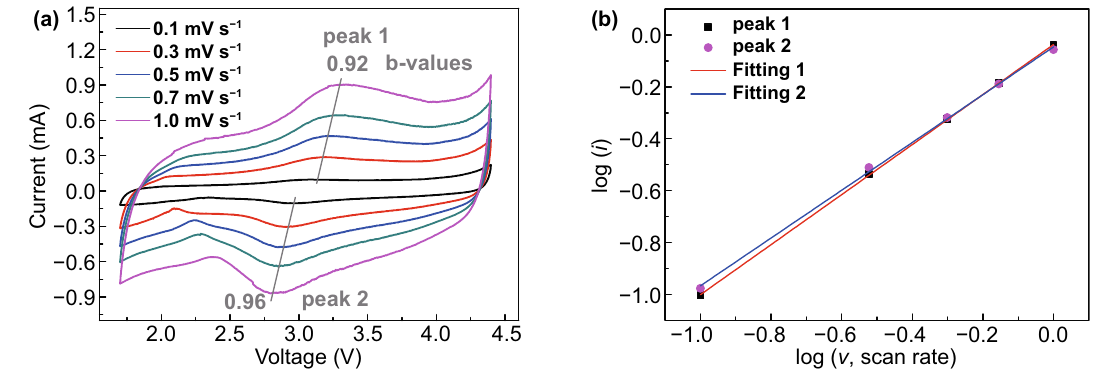
Fig. 9 a CV curves of CuDEPP electrode obtained at various scan rates after initial five cycles between 1.7 and 4.4 V, b log ( i , current) versus log ( v , scan rate) for determining the b